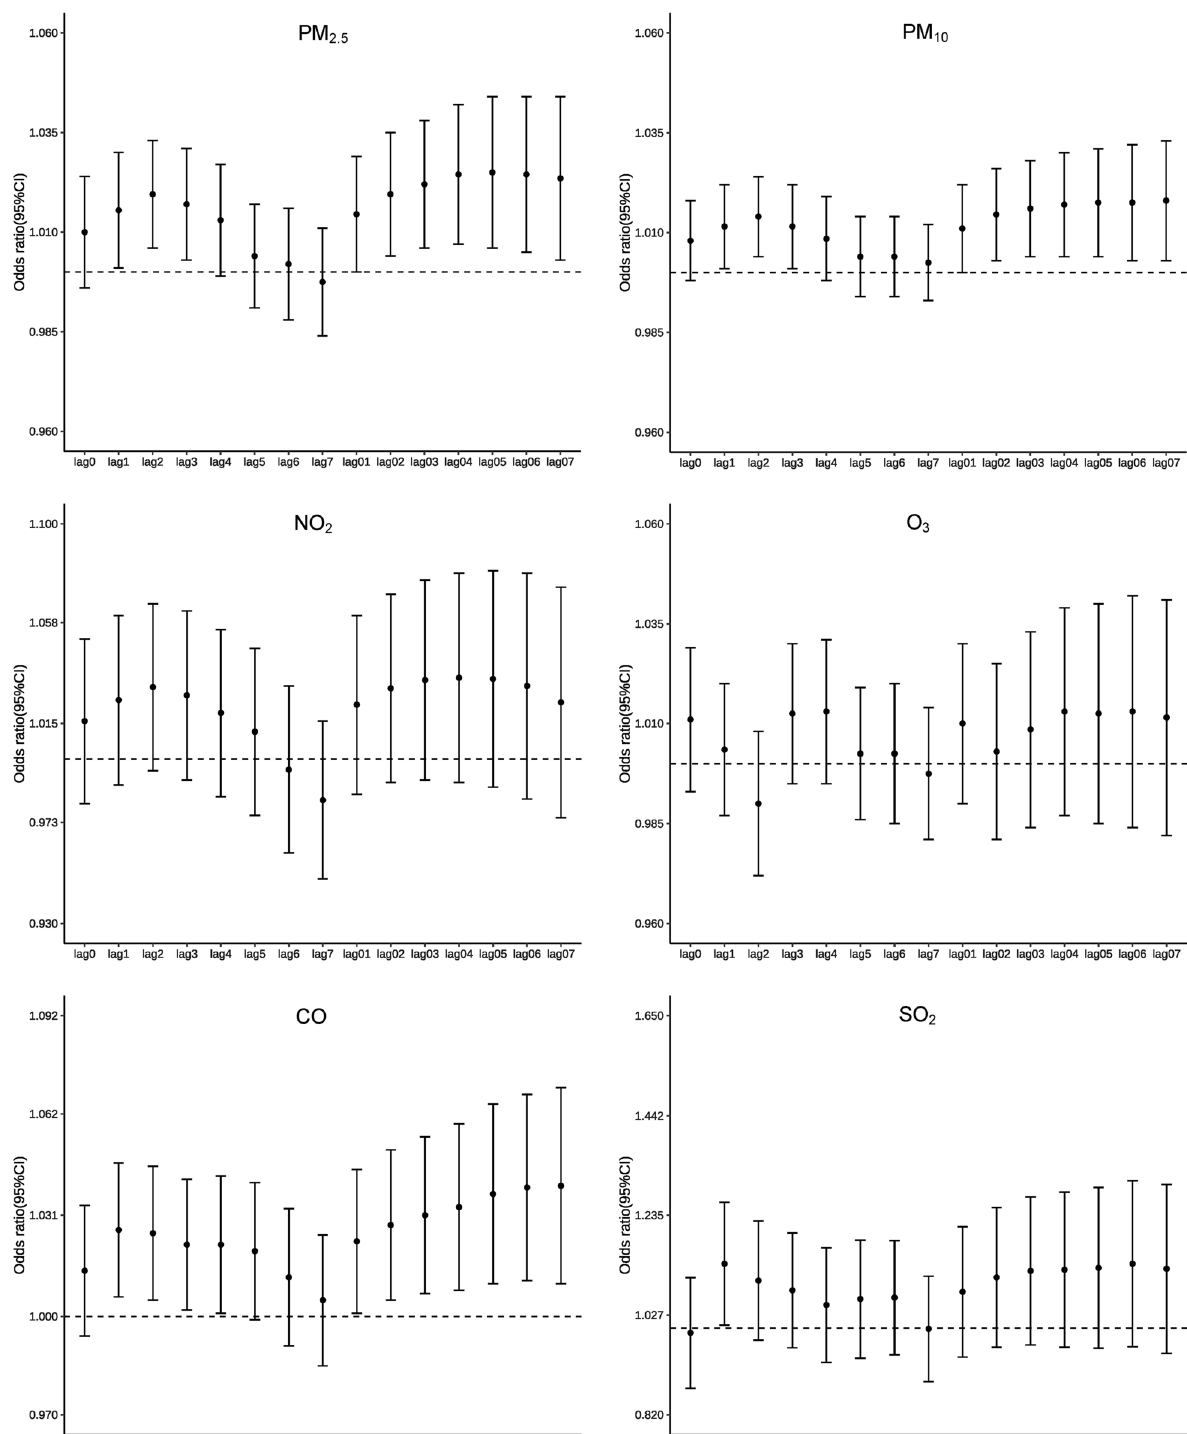
Fig. 1 Changes in the risk of hospitalization in AF patients in a single pollutant